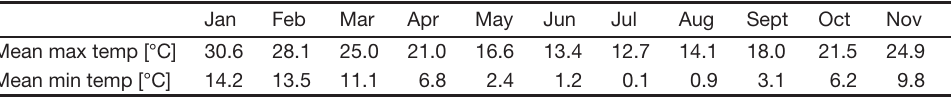
Table 1. Monthly mean temperature in Canberra [25]